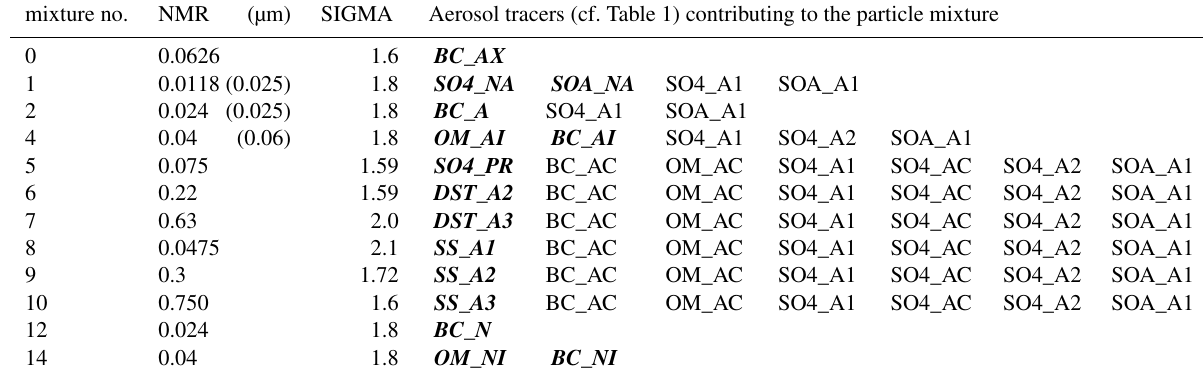
Table 2. Distribution of aerosol tracers in the particle mixtures treated in the model. Tracer names in bold and italic fonts are background tracers, while the others are tracers that modify the size distribution. The initial number median dry radius (NMR) and standard deviation (SIGMA) of each background mode are listed in the second and third column. Also listed (with numbers in brackets) are the prescribed dry NMR values assumed during transport (including atmospheric growth) for the finest particle mixtures (nos. 1, 2, and 4). For other mixtures, the dry sizes of transported tracers are assumed to be identical to the initial sizes. Note that for historical reasons, particle mixture numbers 3, 11, and 13 do not exist in the present model version. For the sake of consistency and transparency, the numbering is the same as in the model code. Assumed dry size parameters for the size-modifying tracers during transport: NMR = 0.04µm and SIGMA = 1.8 for